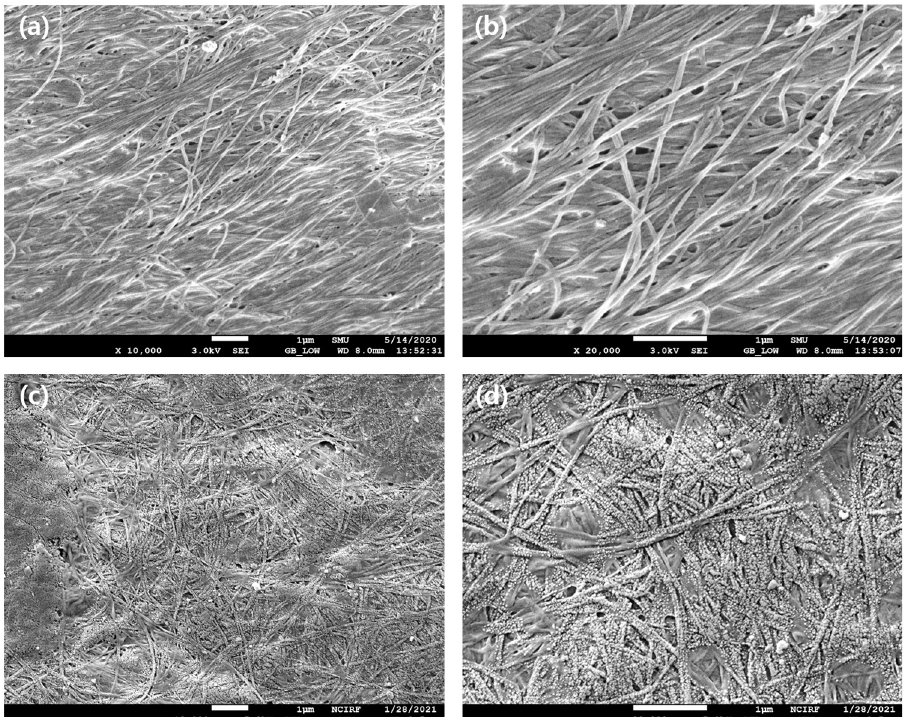
Fig 7. SEM images of a, b original BC; c, d BC-COF bio-leather at 10,000 and 20,000x magnification, respectively, with a scale bar of 1 μ m (Extraction conditions: liquor ratio of 1:10 (w/v), coffee at an amount of 200 wt% BC, 90˚C, 1 h; Dyeing conditions: fabric-to-liquor ratio of 1:10 (w/v), 70˚C, 30 min, meta-mordanting with 1% of FeSO 4 ).